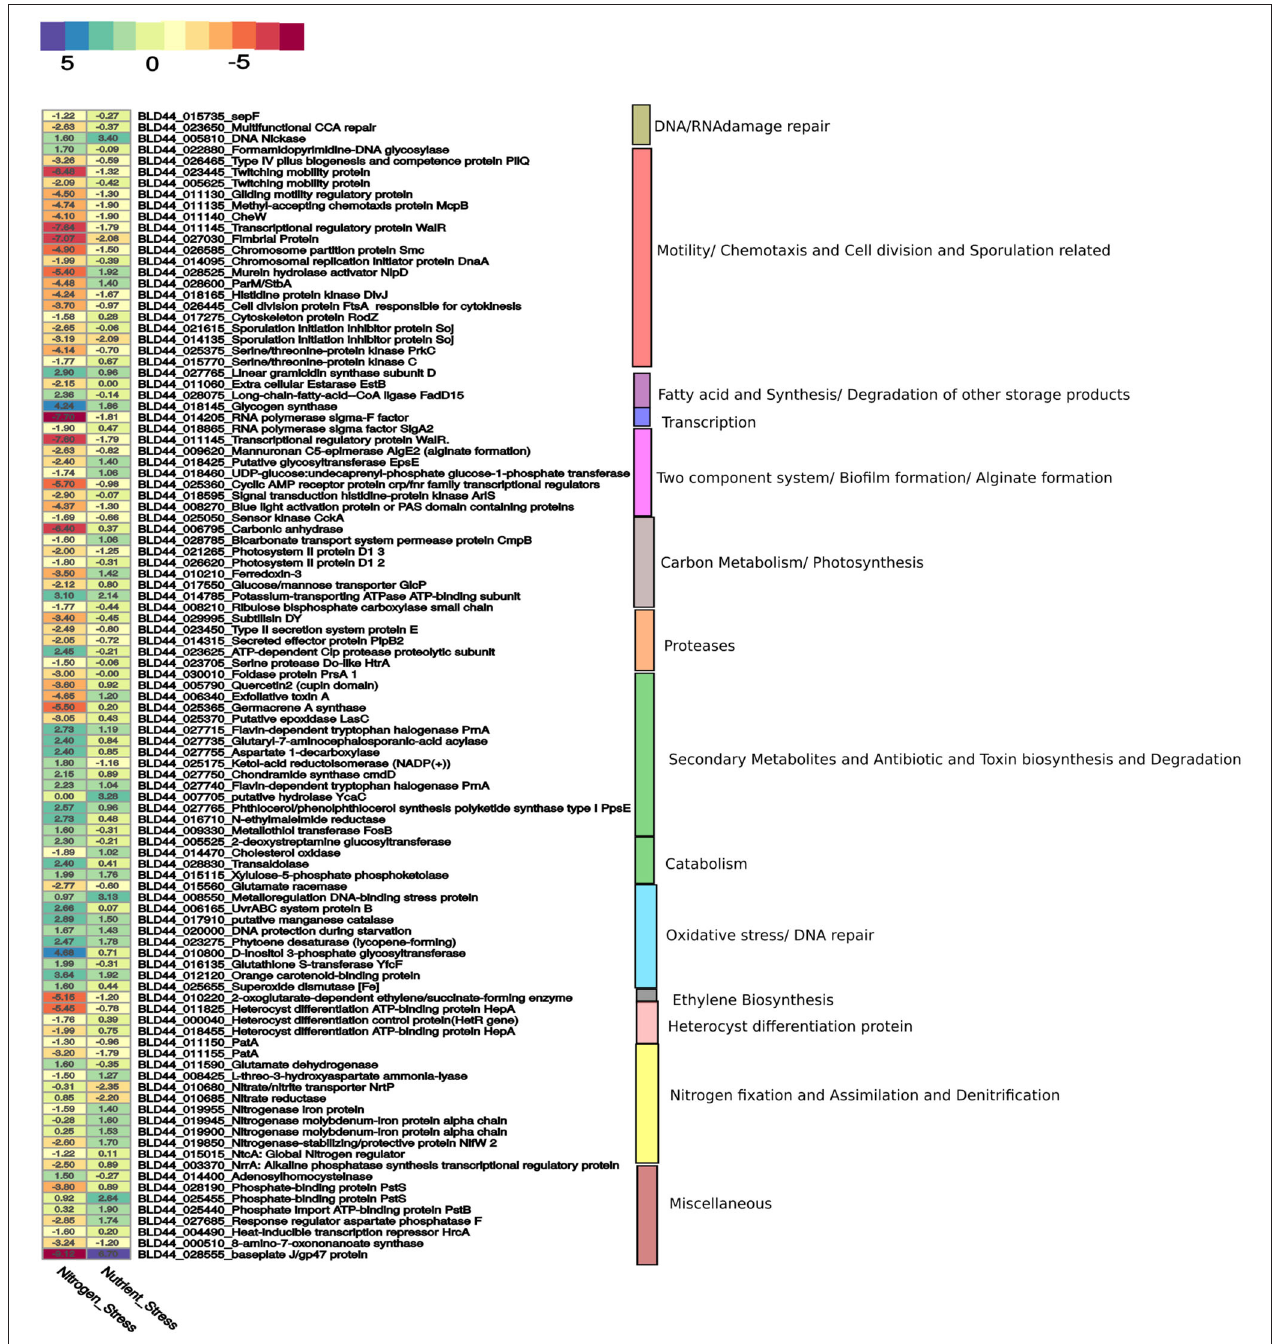
FIGURE 3 | A curated list of genes taken from Supplementary Materials is represented here. The genes for nitrogen stress are represented with N– condition as the reference. For nutrition stress, the 0thday is used as a reference and compared with the 12th day culture under the N– condition. The upregulation and downregulation of the genes are shown in a color-coded heatmap. The gene categories are represented on the right panel.